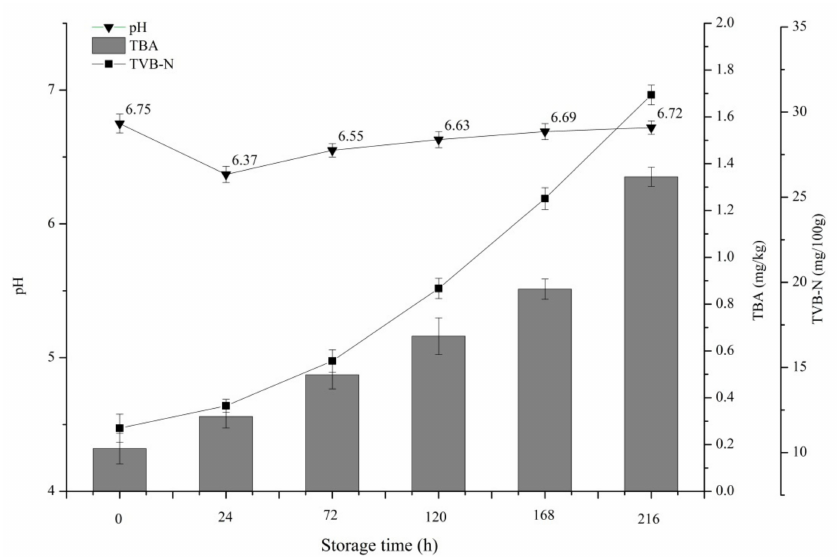
Figure 3. Changes in TVB-N, pH, and TBA of Spanish mackerel at 0 ◦ C cold chain storage conditions. Data represent the mean ± SD values that were obtained from three samples. ( (cid:4) ) represents TVB-N values, ( (cid:72) ) represents pH values, and (dash gray) represents TBA values. Abbreviations: TVB-N, total volatile base nitrogen; TBA, 2-thiobarbituric